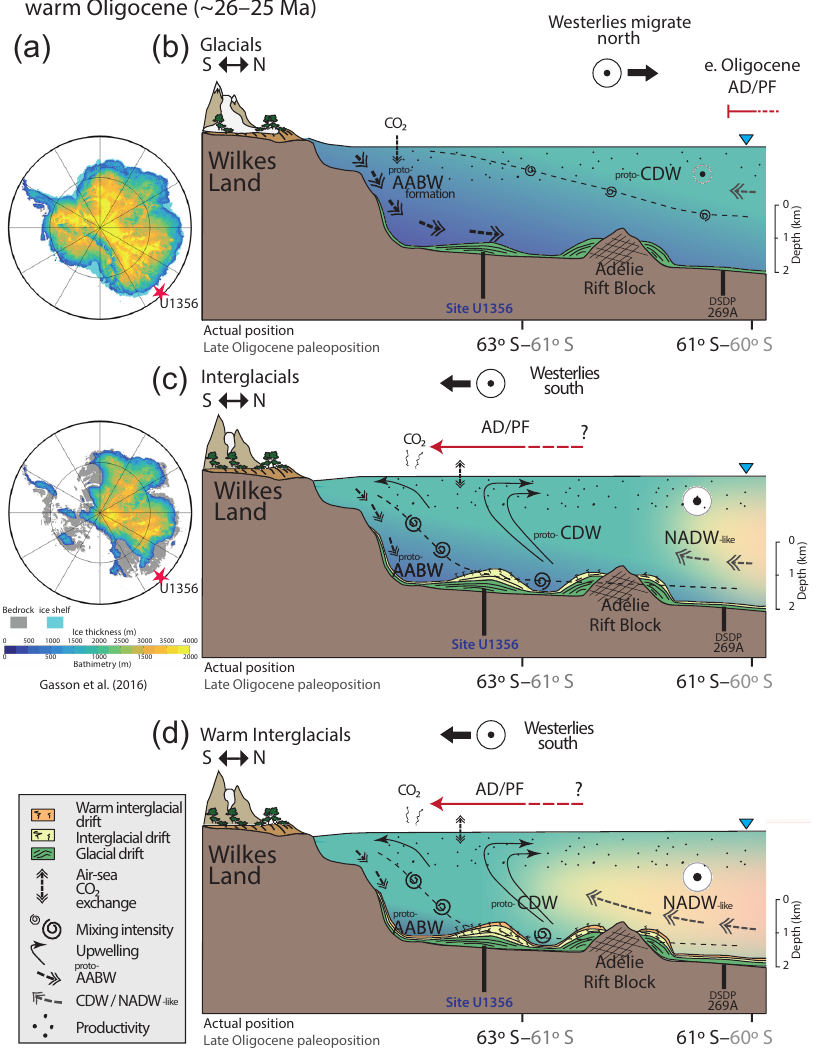
Figure 7. Paleoceanographic reconstructions based on our interpretations for Facies 1 and 2. (a) Modeled ice thickness for the mid-Miocene ice sheet by Gasson et al. (2016). (b) Glacial periods with low-obliquity configuration. Westerlies and polar front (PF) move northwards. There is enhanced proto-AABW formation. Low-ventilation conditions occur at the ocean–sediment interface, and mixing of waters masses is diminished. Bottom currents are weak and fluctuating, producing laminated sediments. (b) Interglacials occur during high-obliquity configuration. Westerlies and the PF move southwards, close to the Site U1356. Proto-AABW formation is reduced. Intrusions of proto- CDW/NADW-like water mass reach southernmost positions. (c) During warm interglacials, NADW-like is enhanced and CaCO3 sedimen- tation is more abundant. (b, c) Bottom water ventilation and upwelling are more vigorous, with stronger bottom currents that result in fully bioturbated and silt-sized